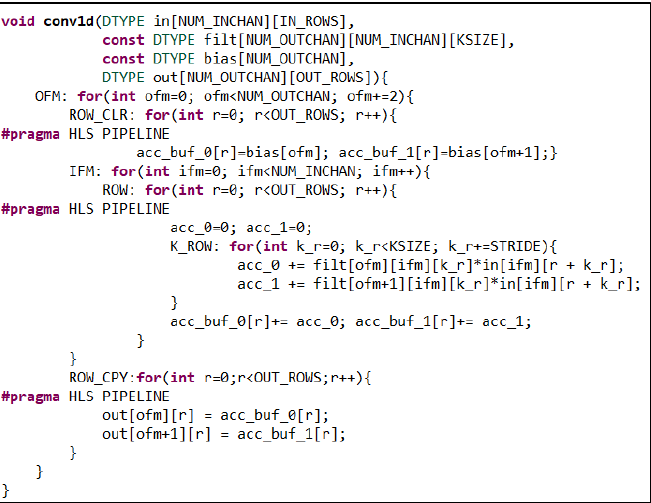
Figure 9. High level synthesis (HLS) code for one ‐ dimensional convolution layer.